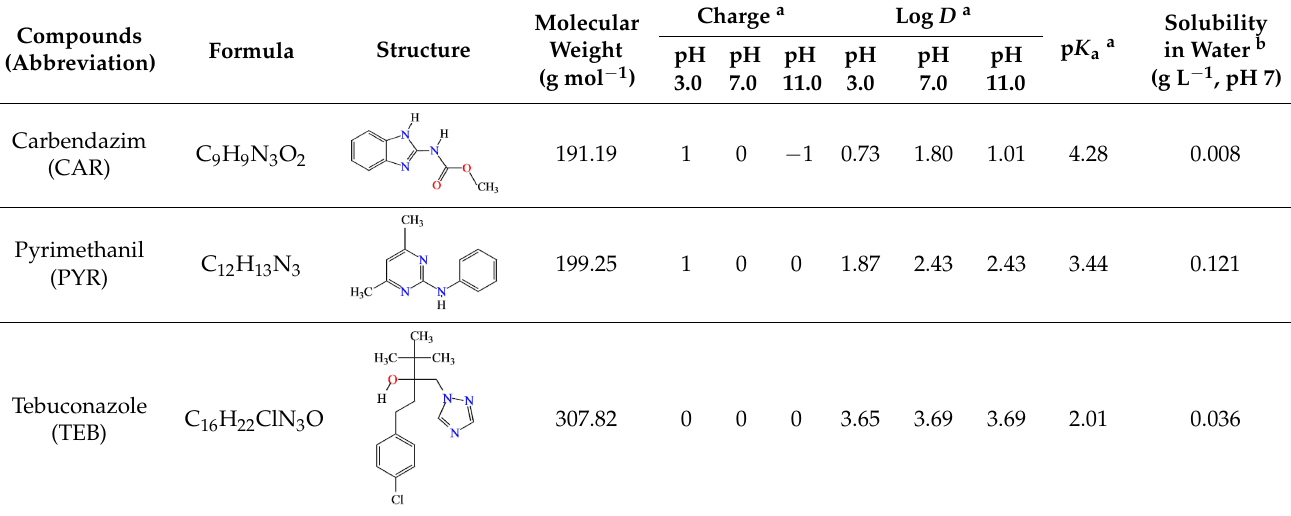
Table 1. Physicochemical properties of the selected fungicides.